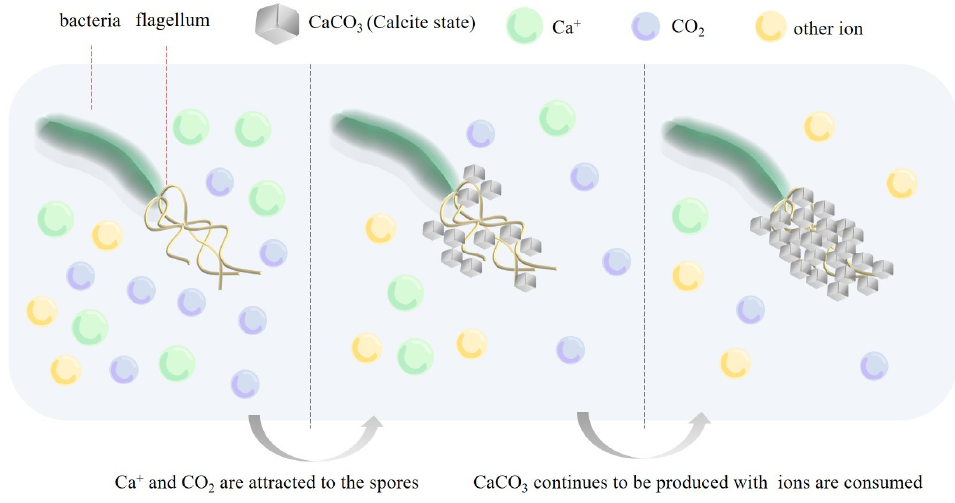
Figure 4. Relationship between repair behavior and ion migration within cracks.